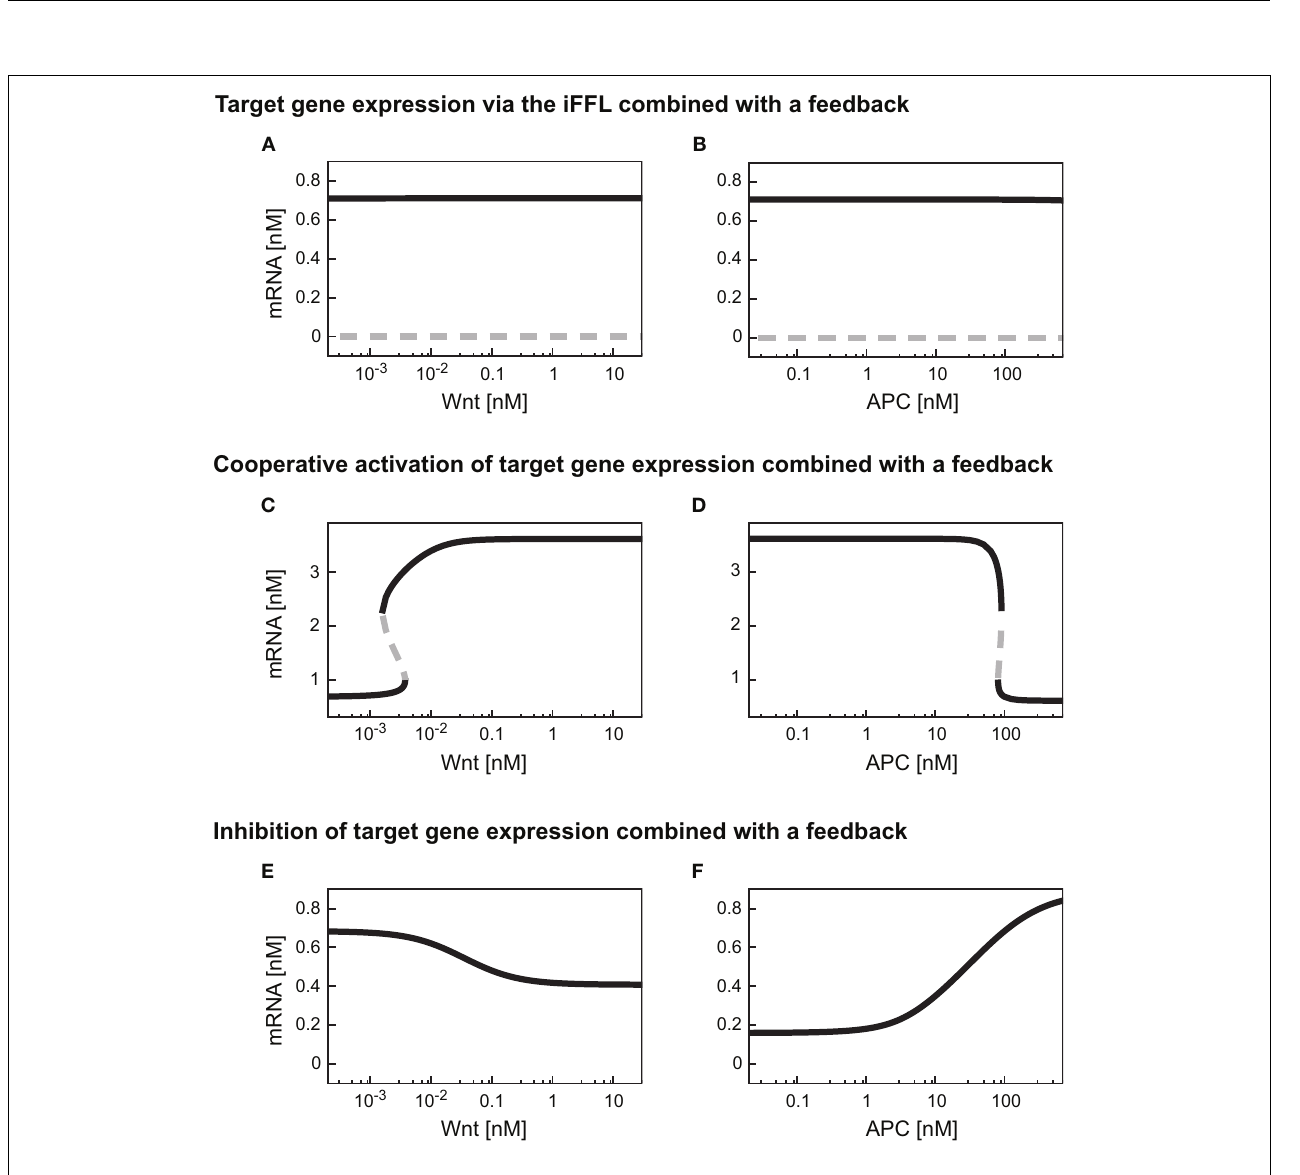
coefficient n = 3 (C,D) , and by inhibition (E,F) are shown within (A,C,E) aWnt gradient or (B,D,F) an APC gradient.The color-code denotes stable steady states as black solid lines and instable steady states as gray dashed